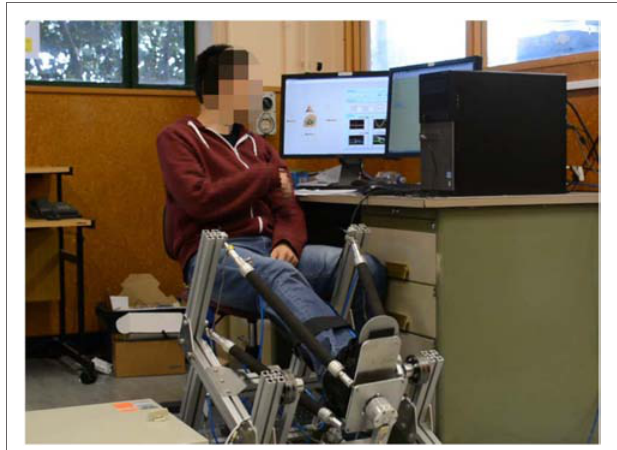
FIGURE 8 | Experimental setup of the human-ankle robot system for compliance control tests. The participant had agreed by written informed consent for using his picture.